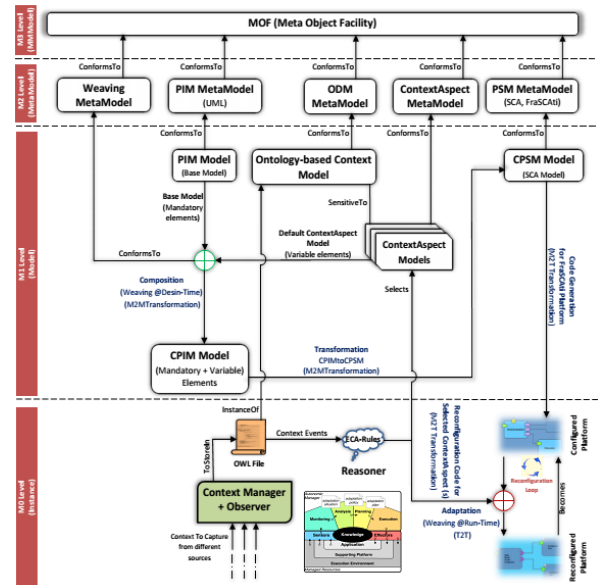
Figure 2. MDA-based Development Approach for